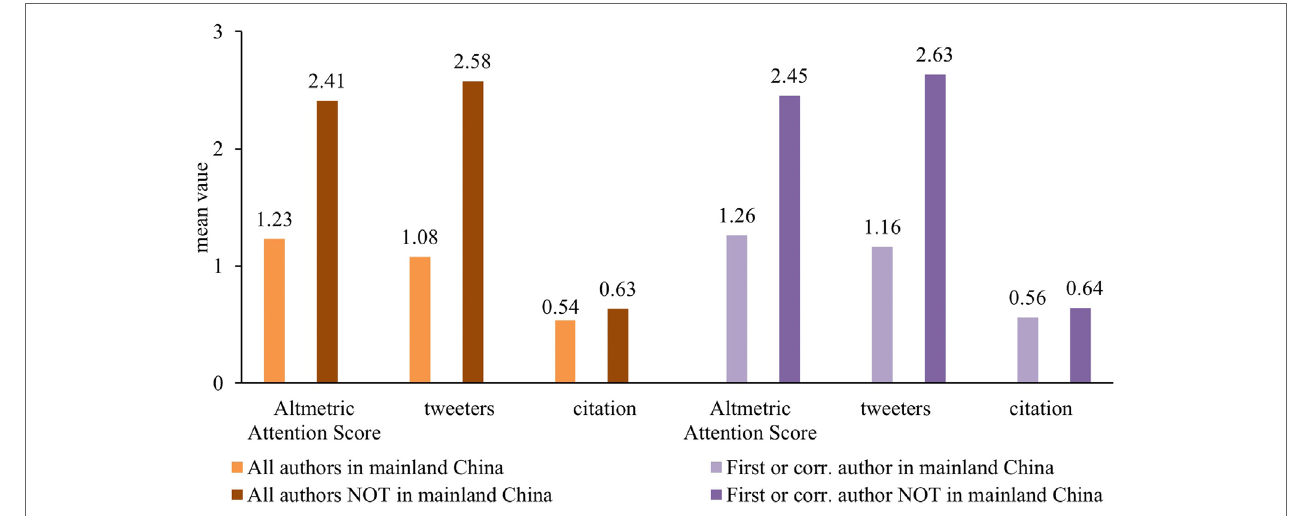
FigUre 1 | comparison of mean altmetric attention scores and tweeters